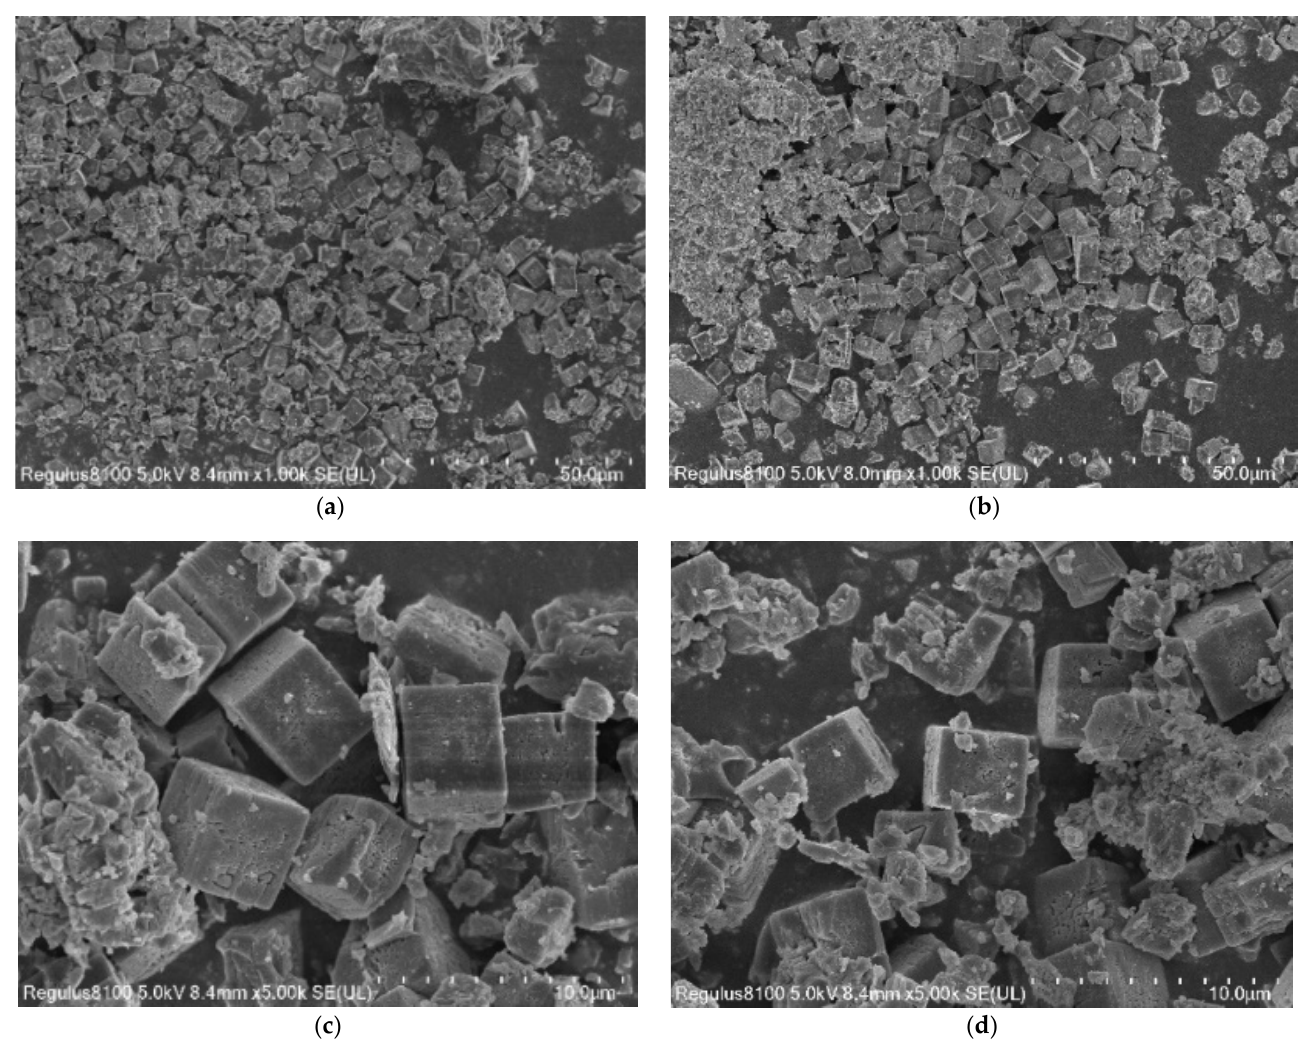
Figure 2. SEM results of the FeO x /SAPO ‐ 34 samples: ( a ) FeO x /SAPO ‐ 34 ‐ 1; ( b ) FeO x /SAPO ‐ 34 ‐ 2; ( c ) FeO x /SAPO ‐ 34 ‐ 3; ( d ) FeO x /SAPO ‐ 34 ‐ 4.